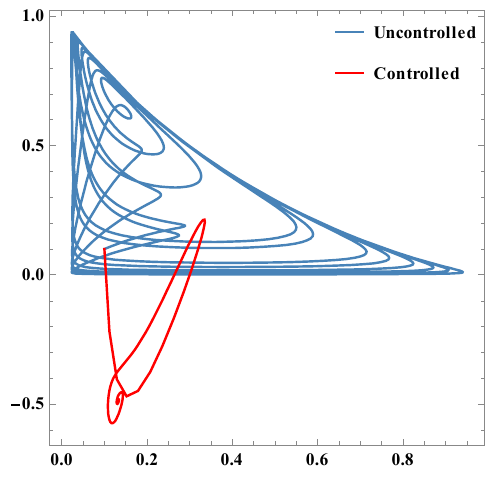
Figure 7. Parametric plots between x 1 & x 2 .